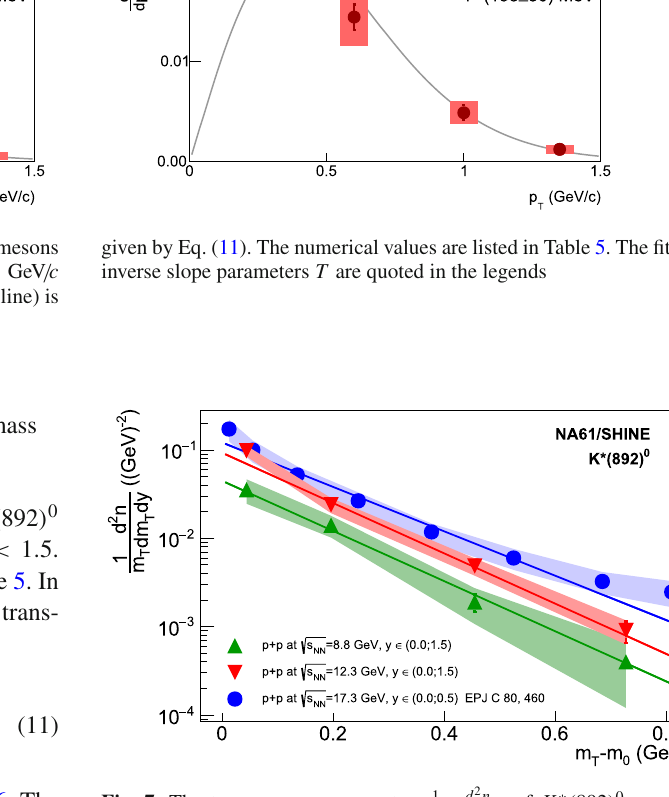
d 2 n Fig. 7 The transverse mass spectra 1 of K ∗ ( 892 ) 0 mesons m T dm T dy produced in inelastic p+p collisions at 40 GeV / c and 80 GeV / c in rapid- ity range 0 < y < 1 . 5. The numerical values are listed in Table 6. The solid lines represent function given by Eqs. (11) and (12) with A and T parameters taken from Fig. 6. For a comparison the previous NA61/SHINE results [9] for p+p interactions at 158 GeV / c are also shown (they were obtained in 0 < y < 0 .